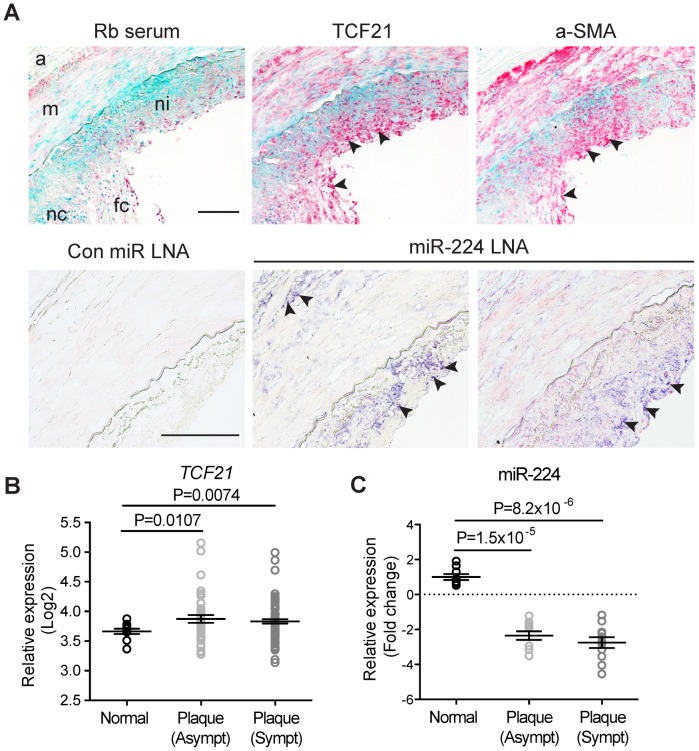
Expression of TCF21 and miR-224 in human atherosclerotic lesions.(A) (Upper panel) Immunohistochemical staining results showing endogenous TCF21 protein expression (in red) in neointima and media regions of left anterior descending (LAD) coronary artery sections (10× magnification). Adjacent sections were incubated with rabbit serum (negative control) or anti-alpha-smooth muscle actin (a-SMA) antibody to localize smooth muscle-like cells. Methyl Green was used as a nuclear counterstain. (Lower panel) Representative in situ hybridization results showing endogenous miR-224 (in indigo) localized in the neointima and adventitia in adjacent LAD sections (20× magnification). Rb: rabbit, LNA: locked nucleic acid. a: adventitia, m: media, ni: neointima, fc: fibrous cap, necrotic core. Arrows denote specific staining. Scale bars = 0.5 mm. (B) Microarray gene expression results showing regulation of TCF21 mRNA and (C) TaqMan quantitative PCR results depicting miR-224 expression, during disease progression in normal, stable and unstable human carotid atherosclerotic lesions (n = 10 per group). Microarray-based expression levels were normalized by robust multi-array average (RMA) and TaqMan-based levels were normalized to the RNU44 internal control. Values represent mean Log2 fold change of replicates and lines represent mean ± SEM. Similar results were observed from two independent experiments.